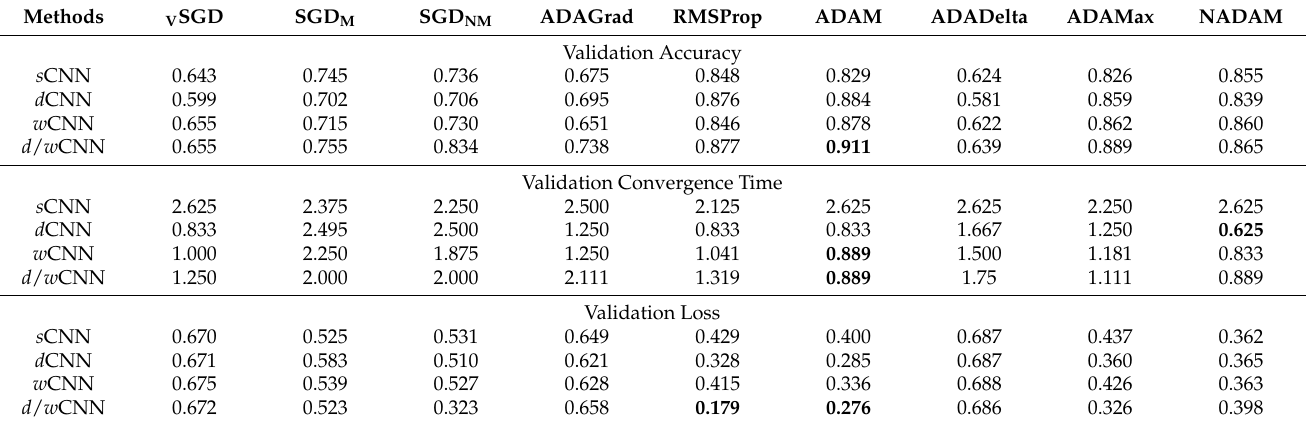
Table 8. Results of optimizers with CNN architectures on Cats and Dogs (epoch = 500).